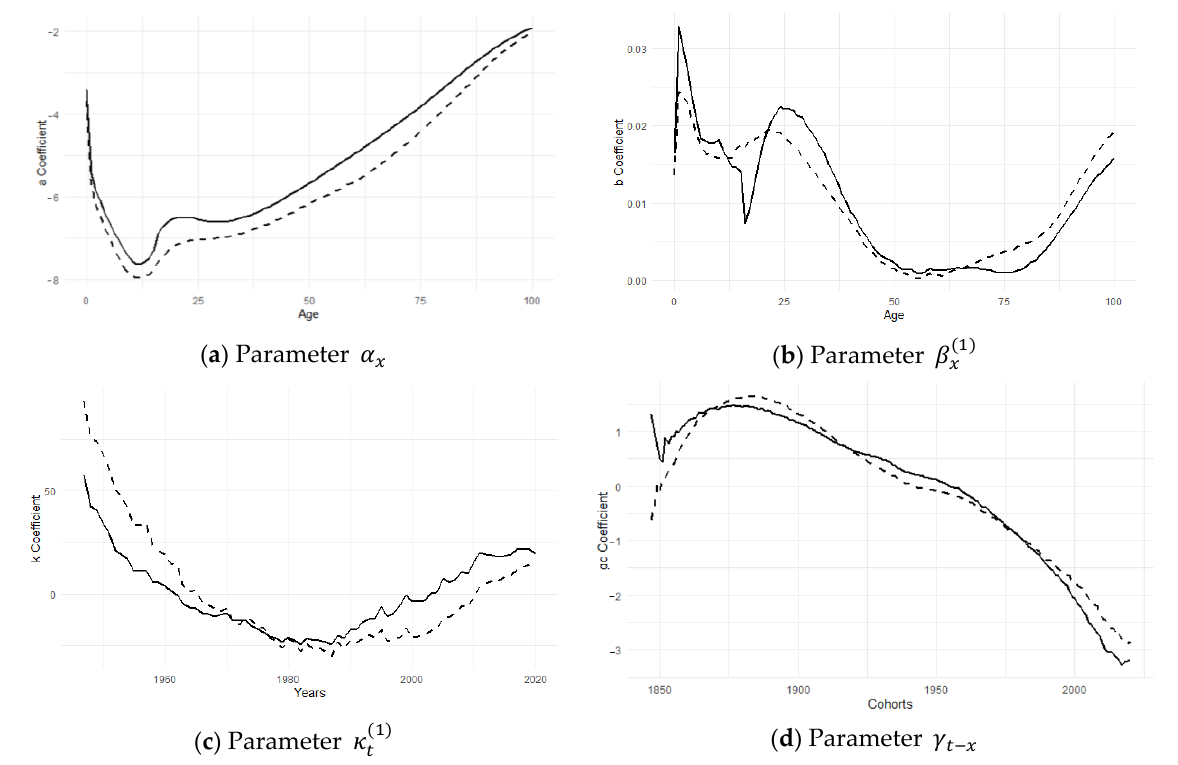
Figure 4. Japan’s RH model for both male (solid line) and female (dashed line).